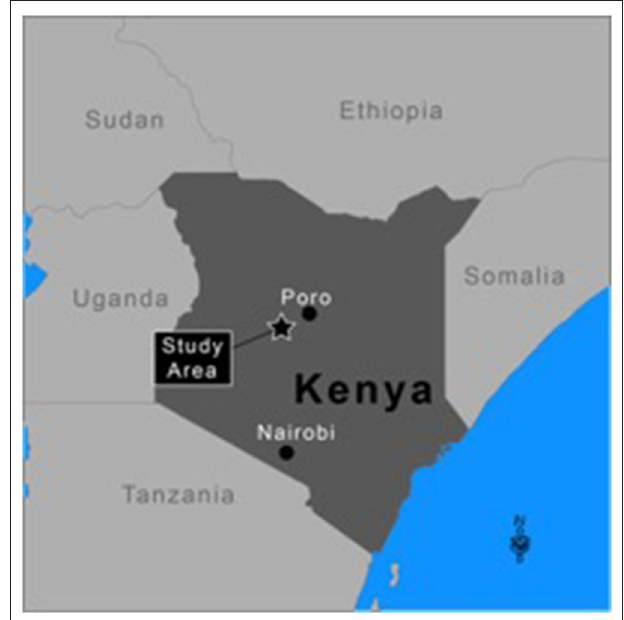
FIGURE 2 | Simulated world reflecting the natural environment of Samburu county.